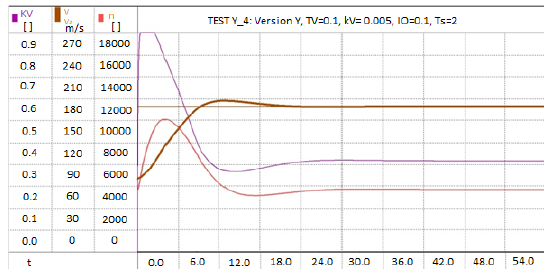
Figure 11. The transitional process of controlling flight speed V , with preset step changes to the velocity V z from 100 to 200m/s. Testing the influence of the coefficient of reinforcement k V = 0.05. The constant of integration I 0 = 0.1